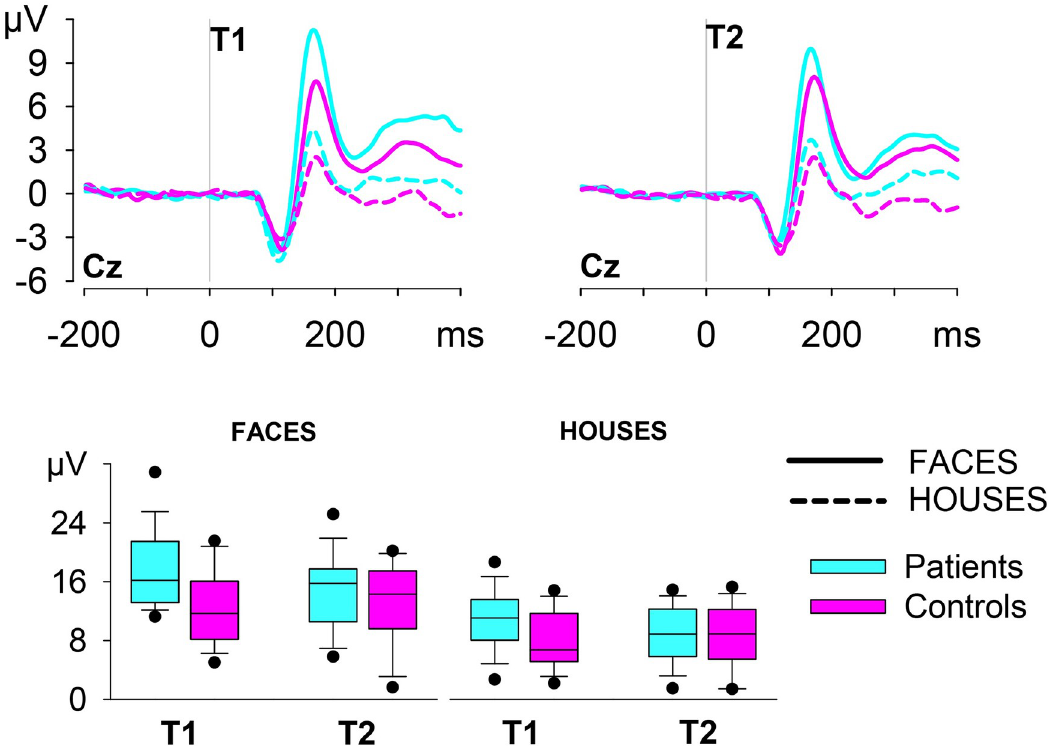
Fig 2. Stimulus-locked ERPs. Grand average ERPs at Cz for the processing of stimuli in patients and controls. Box plots of the median VPP in the two groups at T1 and T2, separately for faces and